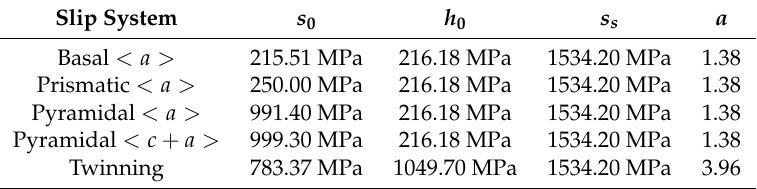
Table 2. Optimum slip system parameters of Ti-7Al.